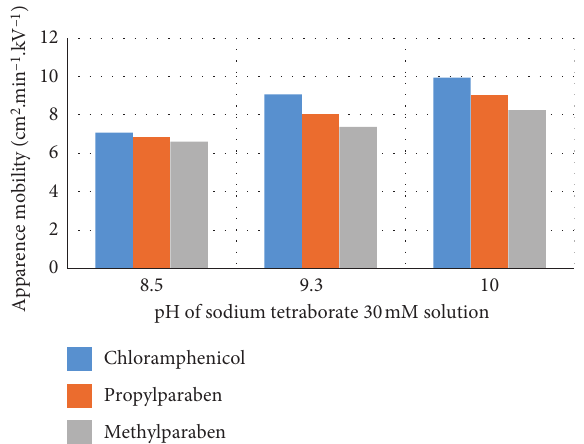
Figure 4: Relationship between the apparent mobility of analytes and pH of sodium tetraborate